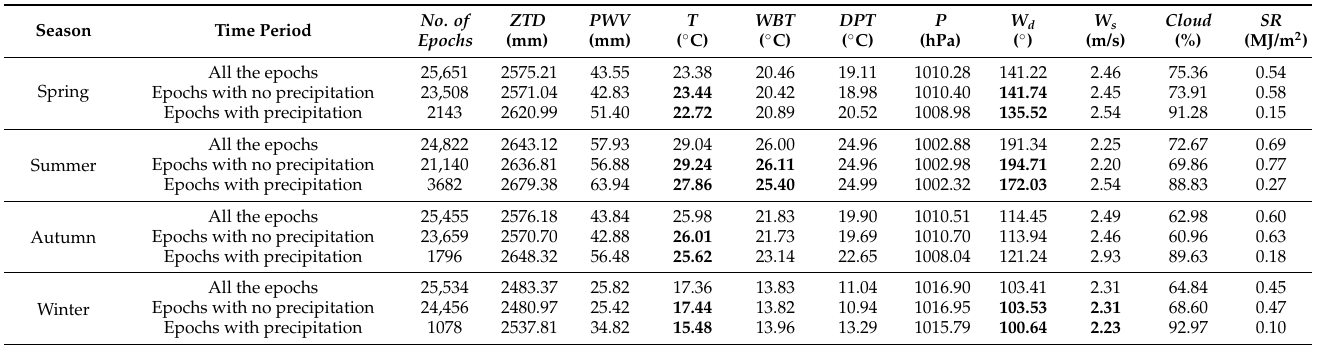
Table 8. Mean values obtained under different precipitation circumstances in the four seasons over the 12-year period